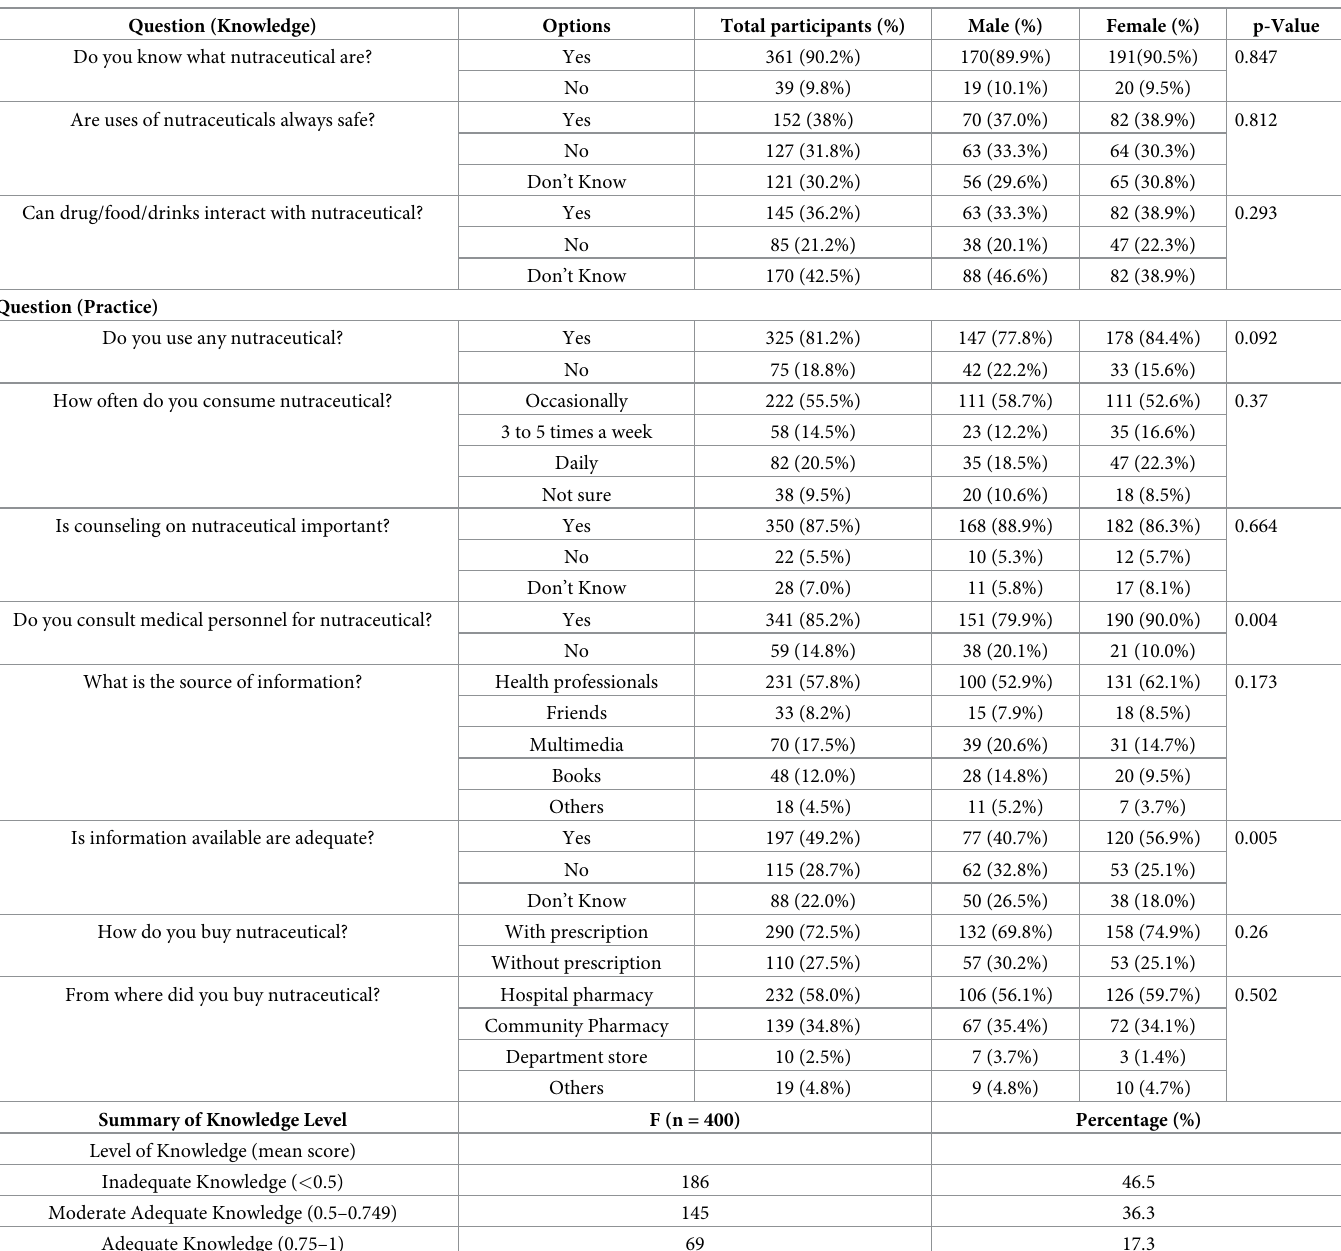
Table 3. Gender wise distribution of knowledge and practice question (Chi-square